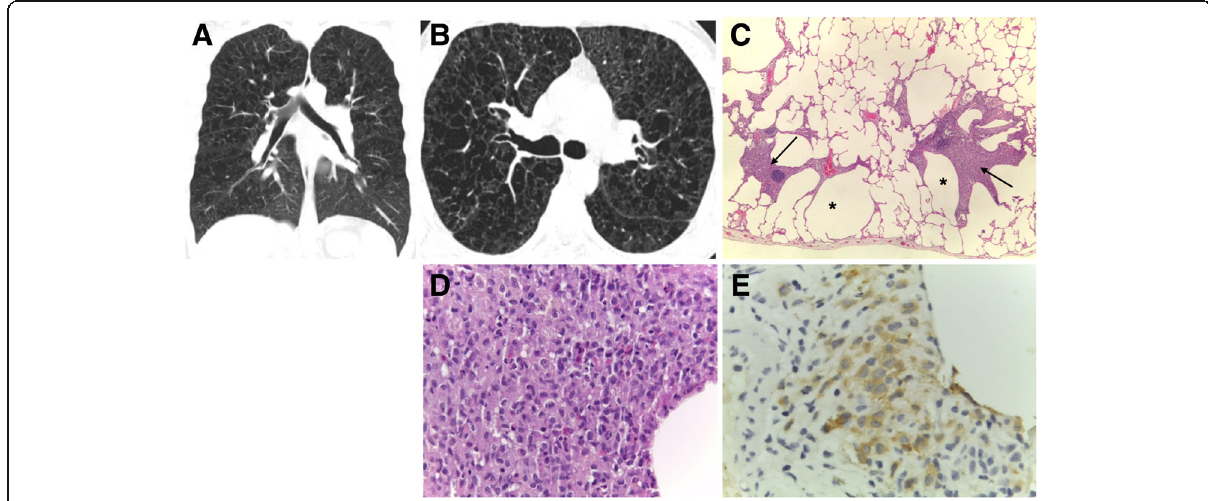
Fig. 11 PLCH. a Coronal and b axial CT images in a 30-year-old man show diffuse upper lobe predominant lucencies with basilar sparing. Imaging findings were thought to represent severe confluent emphysema. c Small cysts (asterisk) with nodular aggregates of Langerhans cells in their walls, with a stellate appearance and centered in bronchioles (arrows) (H&E, ×40). d The cells in the nodules have vesicular nuclei and a pale cytoplasm and